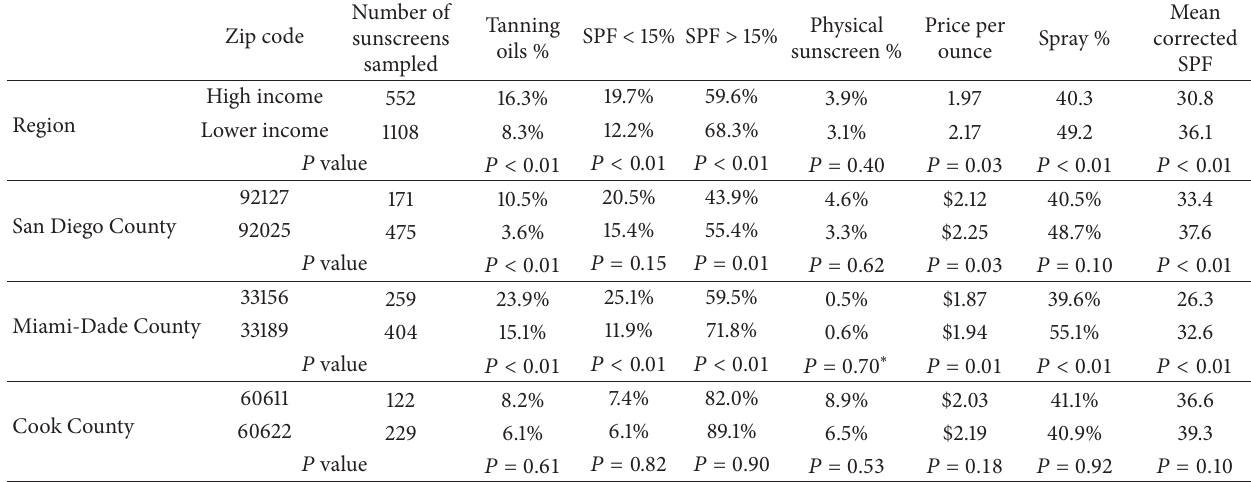
Table 4: Available sun products by zip code with comparisons between high and low income zip codes. “High income” zip codes represent the aggregates 92127, 33156, and 60611. “Low income” zip codes represent the aggregates 92025, 33189, and 60622. Zip code